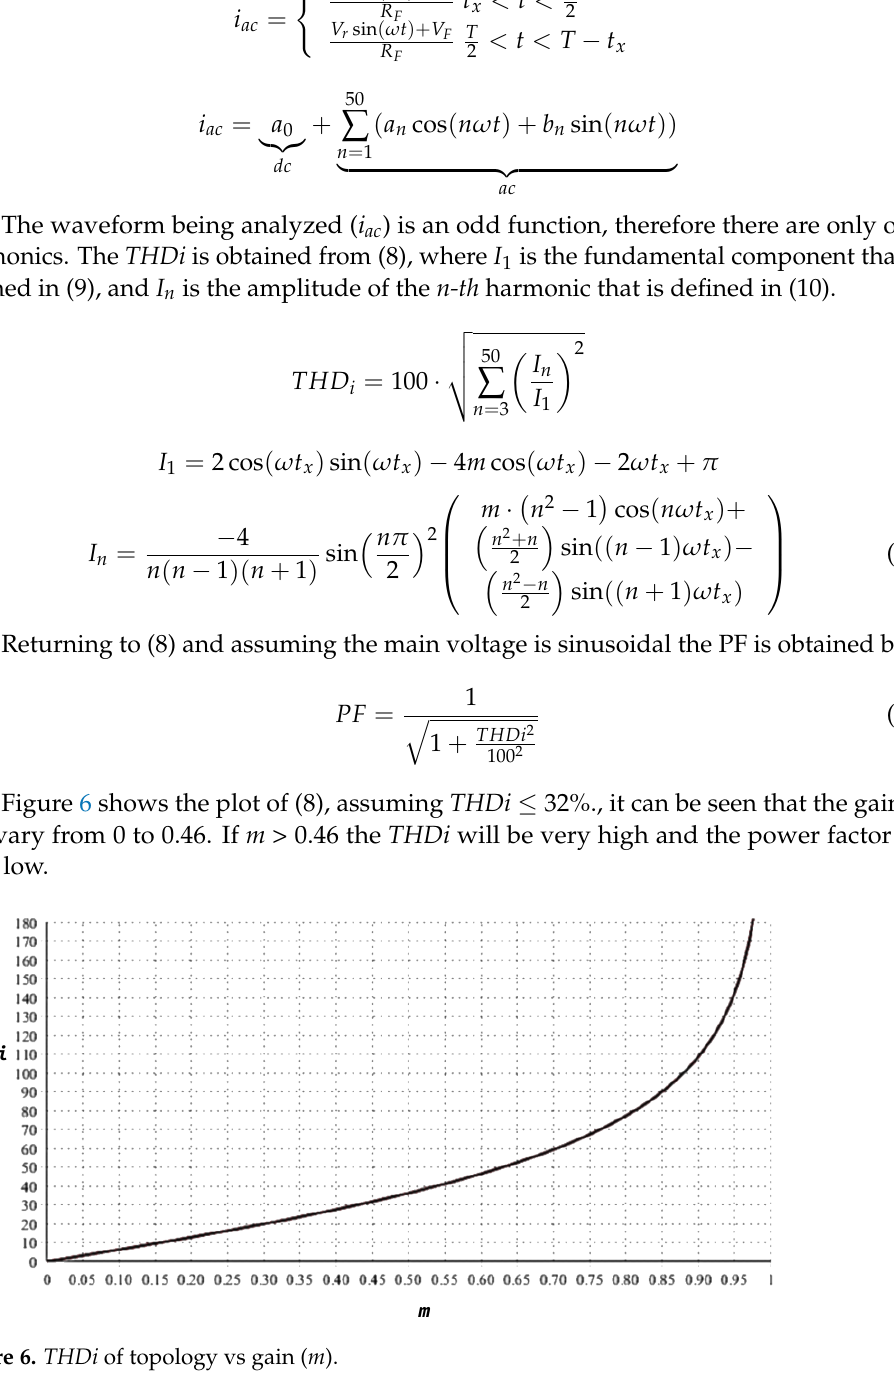
Figure 6. THDi of topology vs gain ( m ).